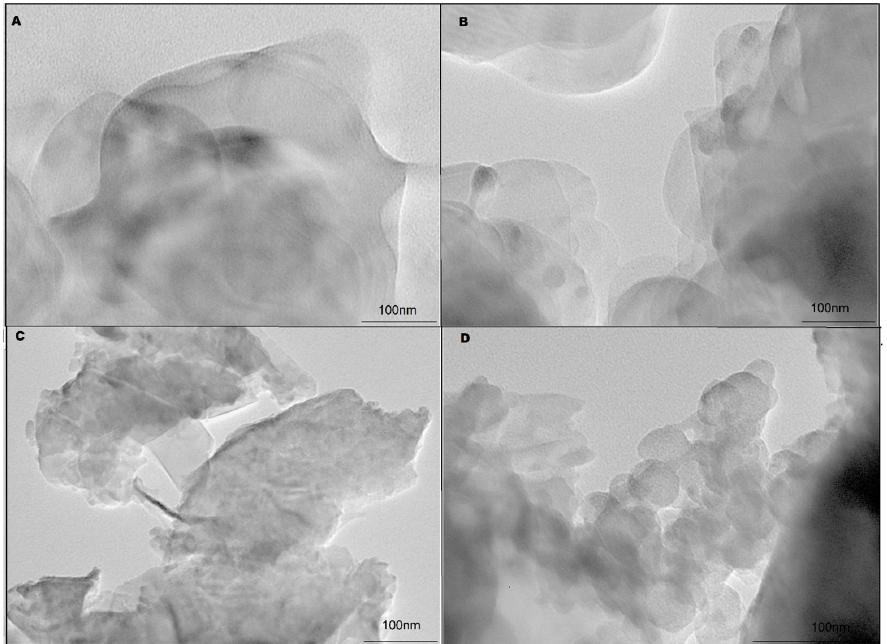
Figure 2. Images ( A ) hBN, ( B ) hBN ‐ ALA ( C ) B 4 C, and ( D ) B 4 C ‐ ALA at 100 nm scale under TEM.